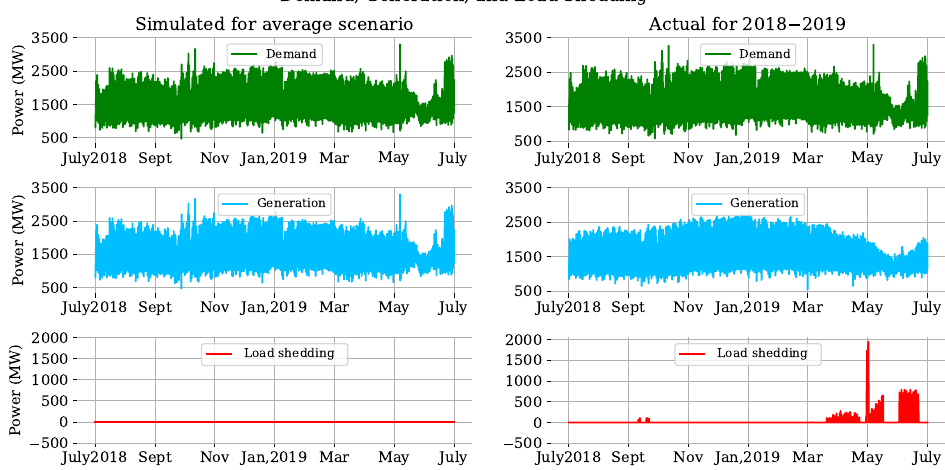
Figure 12. Simulation results for case 1 and actual operation 2018–2019 planning year.